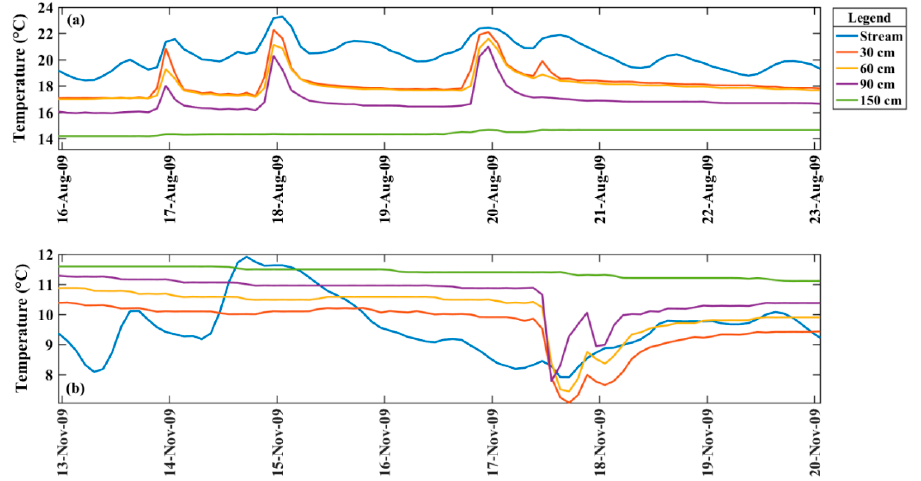
Table 2. Seasonal amplitude averages at each temperature sensor depth.